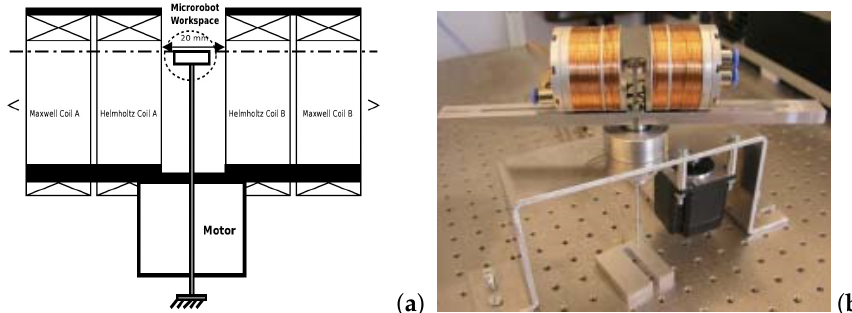
Figure 7. HMr EMA platform developed by Yesin et al. [49]: ( a ) scheme of the concept; and ( b ) a photograph of the magnetic steering